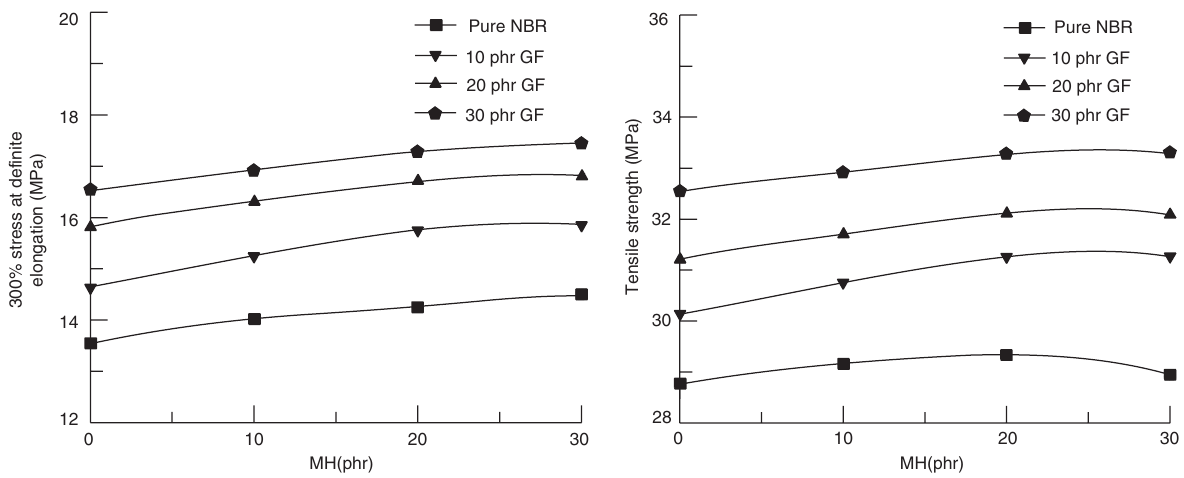
Figure 3 Tensile strength curves for nano MH/GF/NBR composite materials with different MH/GF fraction